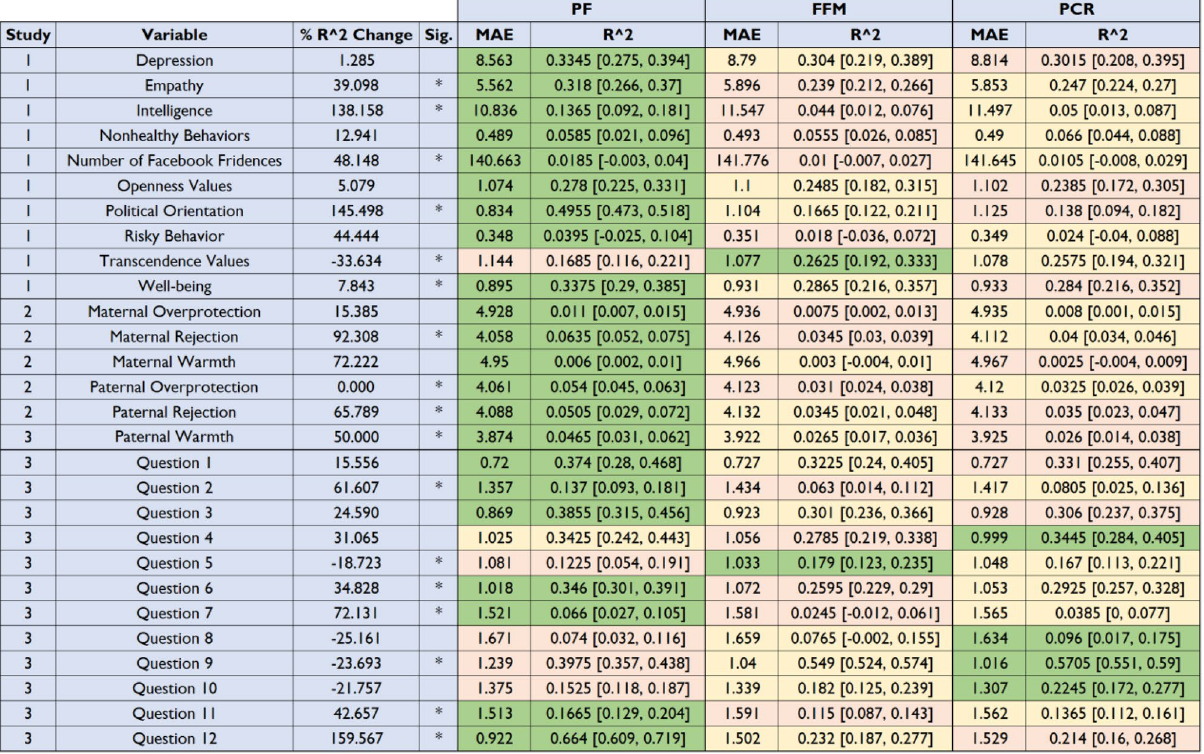
Table 1. Comparison of the predictive performance of the different models. PF—Performance of the model based on the Predictive Five representation; FFM—performance of model based on the Five Factor Model representation; PCR—performance of the Principal Component Regression model; MAE—Mean Absolute Error. For each outcome variable, the most successful model (in terms of predictive accuracy) is colored in green, the second-best model is colored in orange, and the least successful model is colored in pink. Percent R 2 change and significance pertains to the focal comparison (PF-based MAE vs. FFM-based MAE). Significant focal comparisons are denoted by an asterisk, and survive a threshold of p < .05, FDR corrected. In 14 cases, the PF-based model significantly outperformed the FFM-based model, in 3 cases, the FFM-based model was significantly better than the PF-based model.